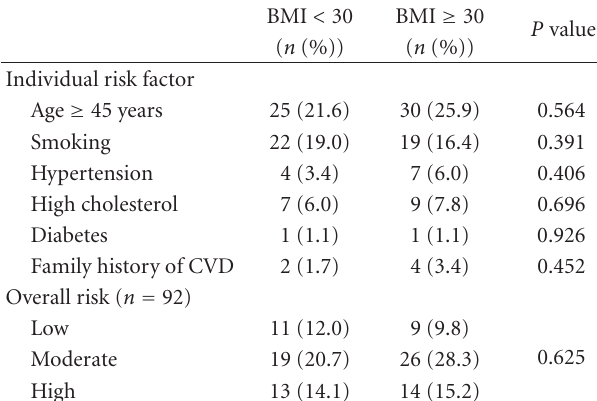
Table 3: Influence of obesity on cardiovascular disease risk factors.